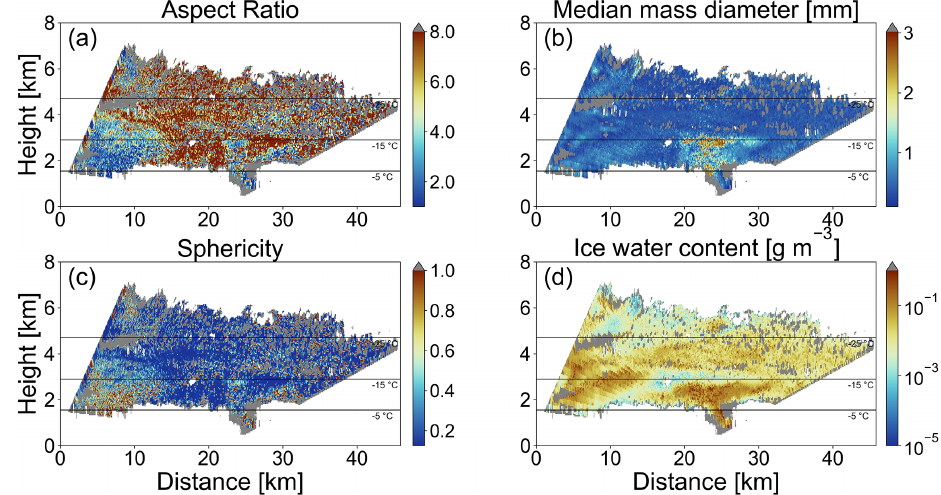
Figure 15. Retrieved (a) AR, (b) D m , (c) S , and (d) IWC for oblate ice particles for 30 January 2019 at 10:08UTC using BF95 m(D max ) . The − 5, − 15, and − 25 ◦ C temperature levels are plotted with black solid lines (source: Deutscher Wetterdienst, data provided by Univer- sity of Wyoming; http://weather.uwyo.edu/upperair/sounding.html, last access: 8 April 2022). Areas where ice-masked and noise-filtered measurement values are located are plotted with gray.